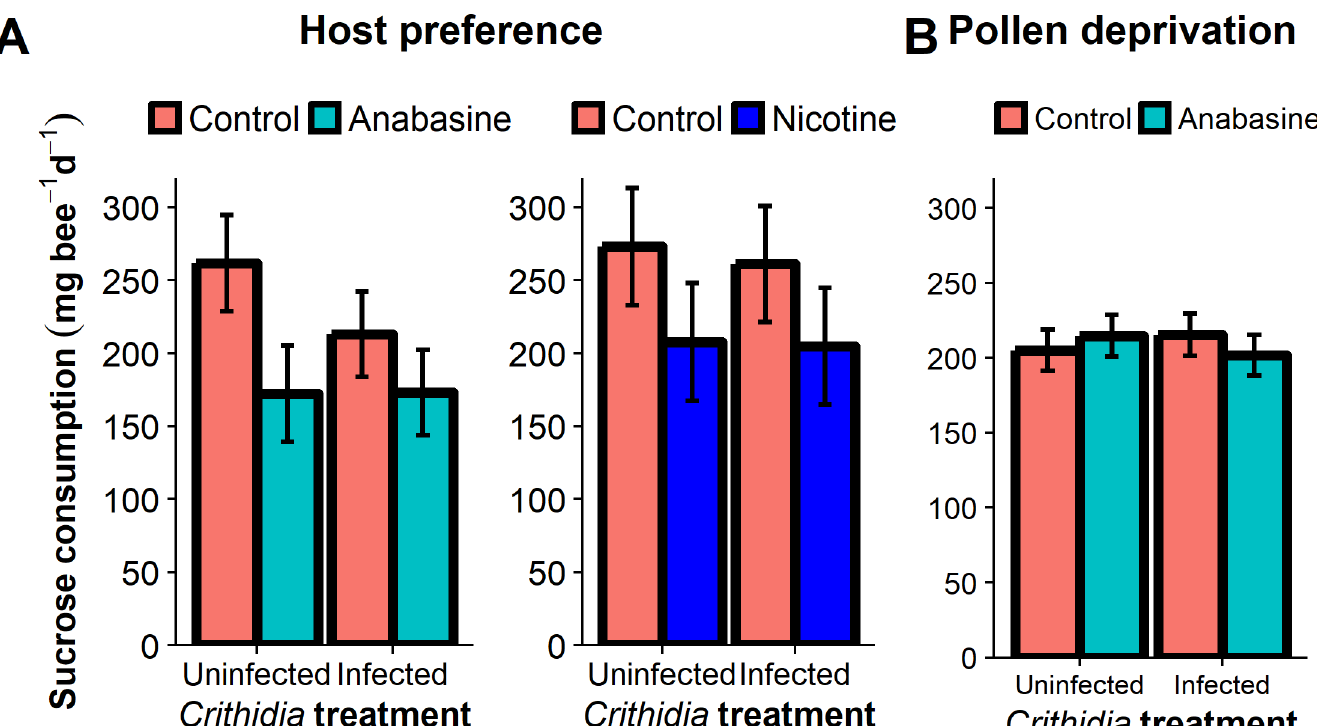
Fig 2. Effects of Crithidia infection and 5 ppm anabasine or 2 ppm nicotine on consumption of sucrose solutions and pollen in choice (A) and no-choice (B) experiments. (A) Host PreferenceExperiments, in which individualbees were given a choice between30% sucrose solutionswith and without 5 ppm anabasine or 2 ppm nicotine.The 24 h trial was conducted7 d post-infection. (B) PollenDeprivation Experiment solutionconsumption by individualbees under no-choice conditions. Consumption was measuredover the entire experiment (7 d). Bars and error bars represent model means and standard errors. Red bars: 30% sucrose control. Teal bars: 5 ppm anabasine. Blue bars: 2 ppm nicotine.